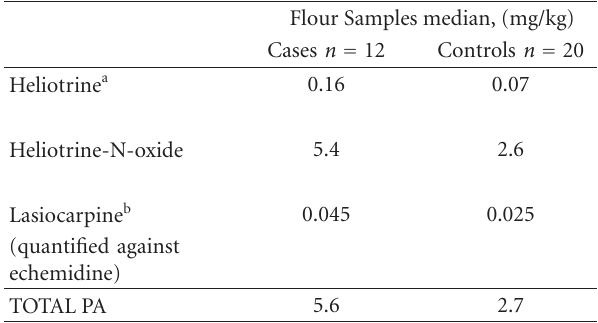
Table 4: PA content of thirty-two flour samples collected from a ff ected villages, Gulran District, Afghanistan, 2008. Flour Samples median, (mg/kg)